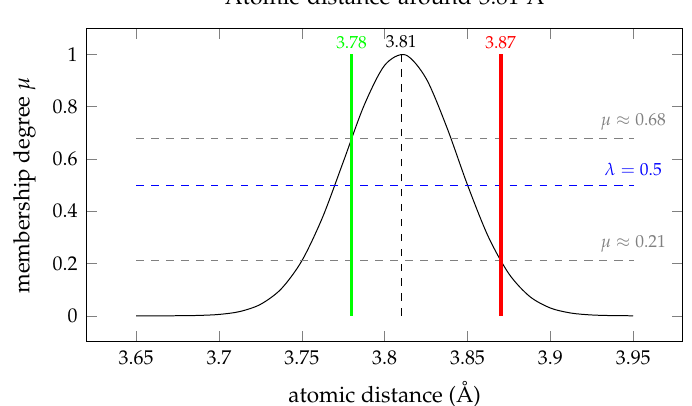
Figure 8. Visual interpretation of fuzzy selection with the fuzzy search condition Atomic distance around 3.81 Å showing two values of the inter-atomic distance in protein structures: 3.78 that satisfies the condition ( µ ( 3.78 ) > λ ), and 3.87 that does not satisfy the condition ( µ ( 3.87 ) < λ ) for λ = 0.5. Such a U-SQL code generates the report shown in Figure 9, which is saved to CSV files in the Azure cloud storage by executing the OUTPUT statements S 5 in lines 65–67. This report shows residues with values of the C α – C α distance around 3.81Å accompanied by membership degrees, which constitute degrees of truth how the particular distance value matches the fuzzy selection condition.